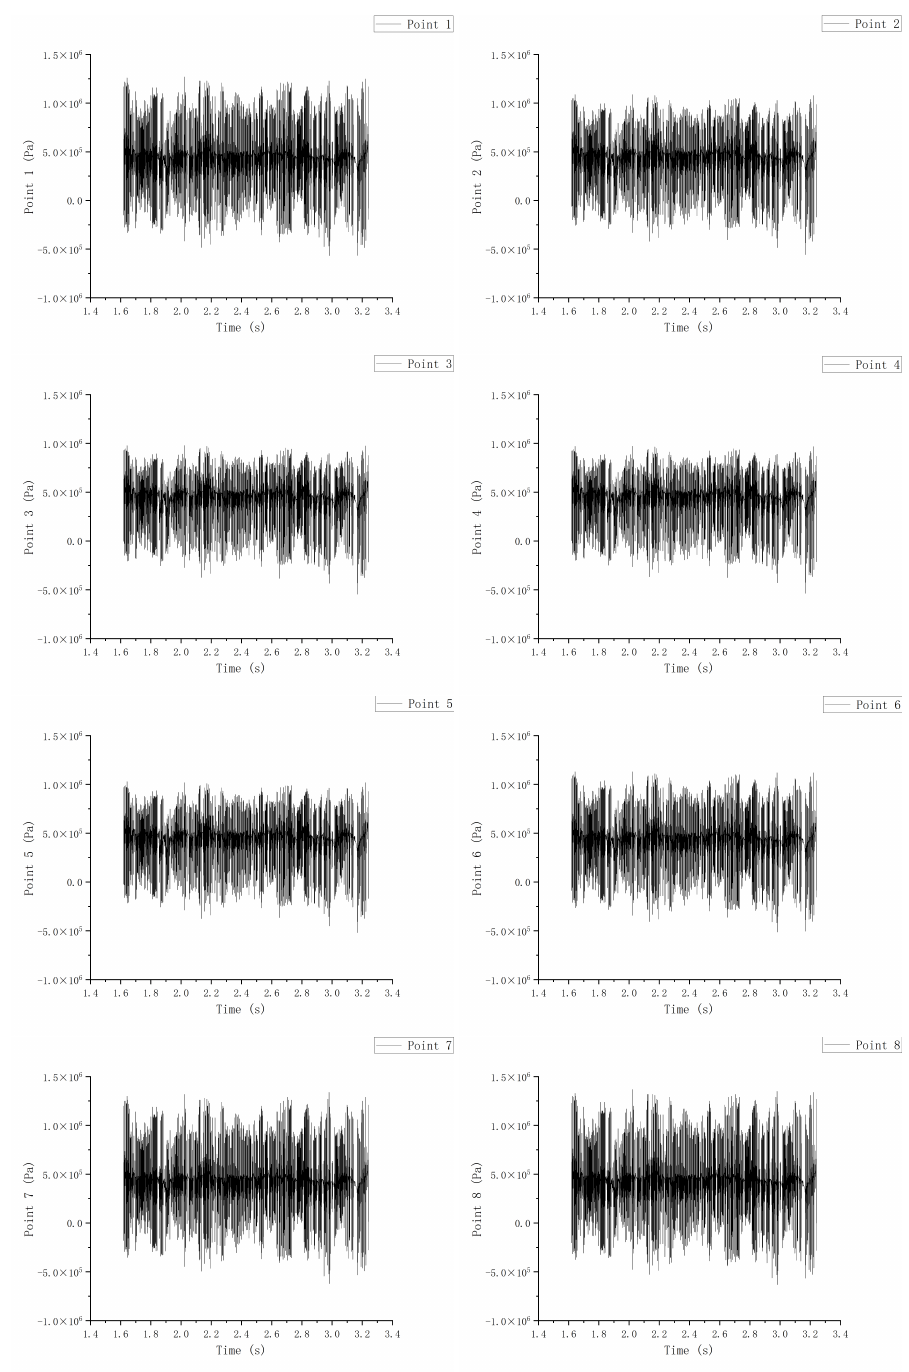
Figure 18. The pressure distributions of the middle crown